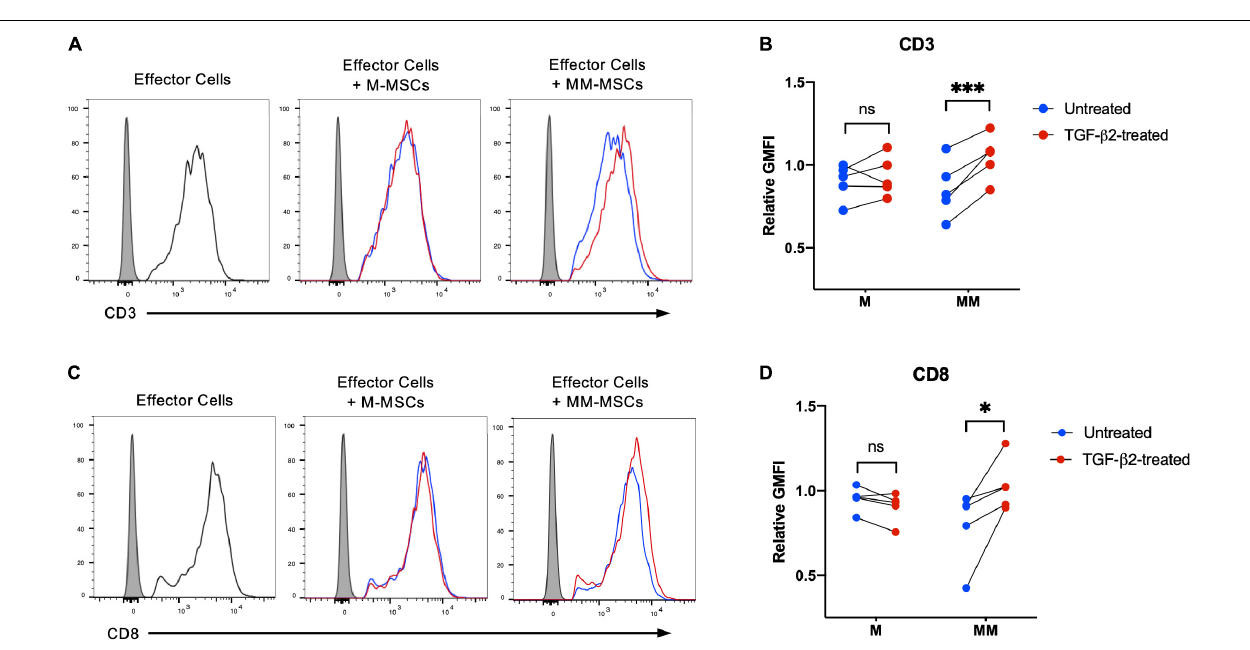
FIGURE 3 | TGF- β 2 treatment of MHC-mismatched MSCs prevents activation of T cells. (A) Representative histograms of CD3 expression on effector lymphocytes from one horse cultured with MHC-matched or MHC-mismatched untreated or TGF- β 2-treated MSCs. (B) CD3 expression on effector lymphocytes relative to effector cells incubated without MSCs. MSC donor-paired samples are represented by connected lines for n = 5, *** p = 0.0016 by a one-sample t -test on each pair. (C) Representative histograms of CD8 expression on effector lymphocytes from one horse cultured with MHC-matched or MHC-mismatched untreated or TGF- β 2-treated MSCs. (D) CD8 expression on effector lymphocytes relative to effector cells incubated without MSCs. MSC donor-paired samples are represented by connected lines for n = 5, * p = 0.0223 by a one-sample t -test on each